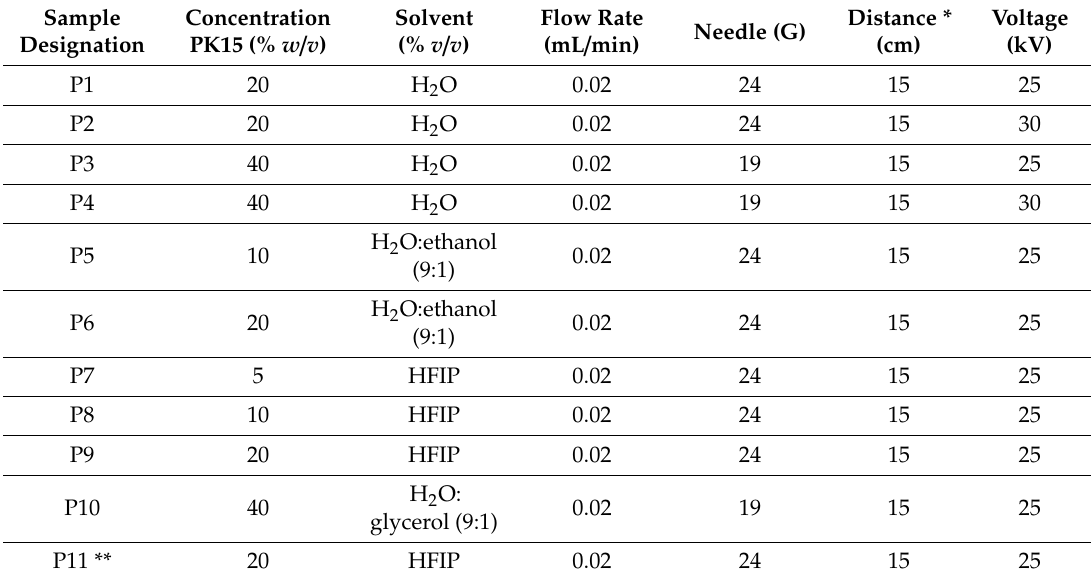
Table 2. Potato protein solutions and electrohydrodynamics processing parameters